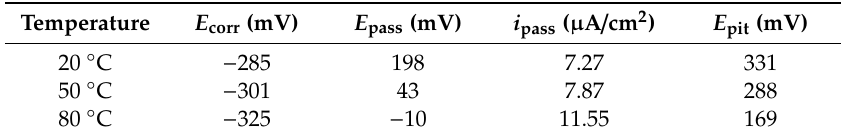
Table 2. Electrochemical parameters obtained from polarization curves at 20 °C, 50 °C, and 80 °C (the E value referred to the Ag/AgCl electrode).